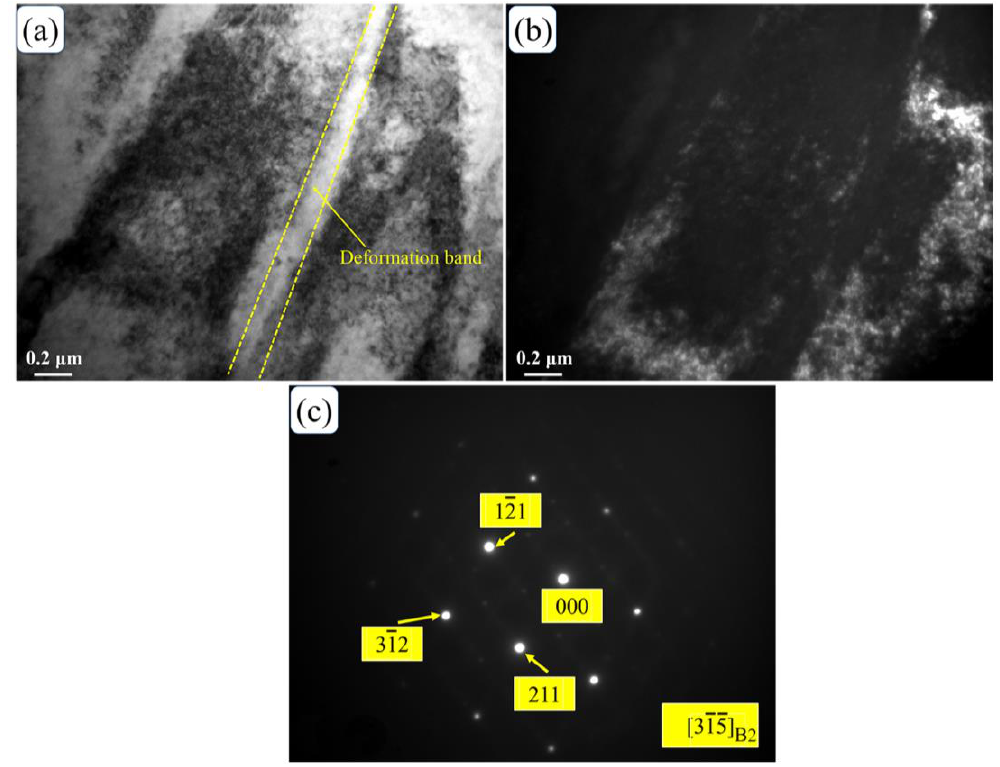
Figure 1. TEM micrographs of NiTi SMA sample subjected to uniaxial compression at the deformation degree of 40%: ( a ) bright field image; ( b ) dark field image; ( c ) SAED (selected area electron diffraction) pattern of ( b ).